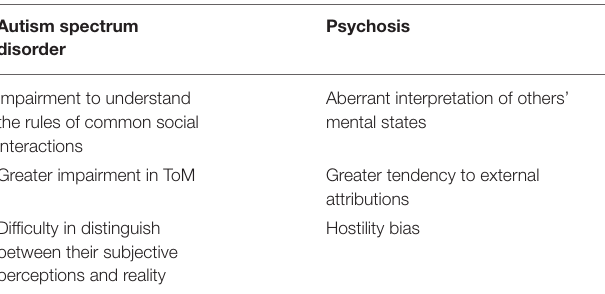
TABLE 1 | Key elements for the differential diagnosis of delusions in ASD and